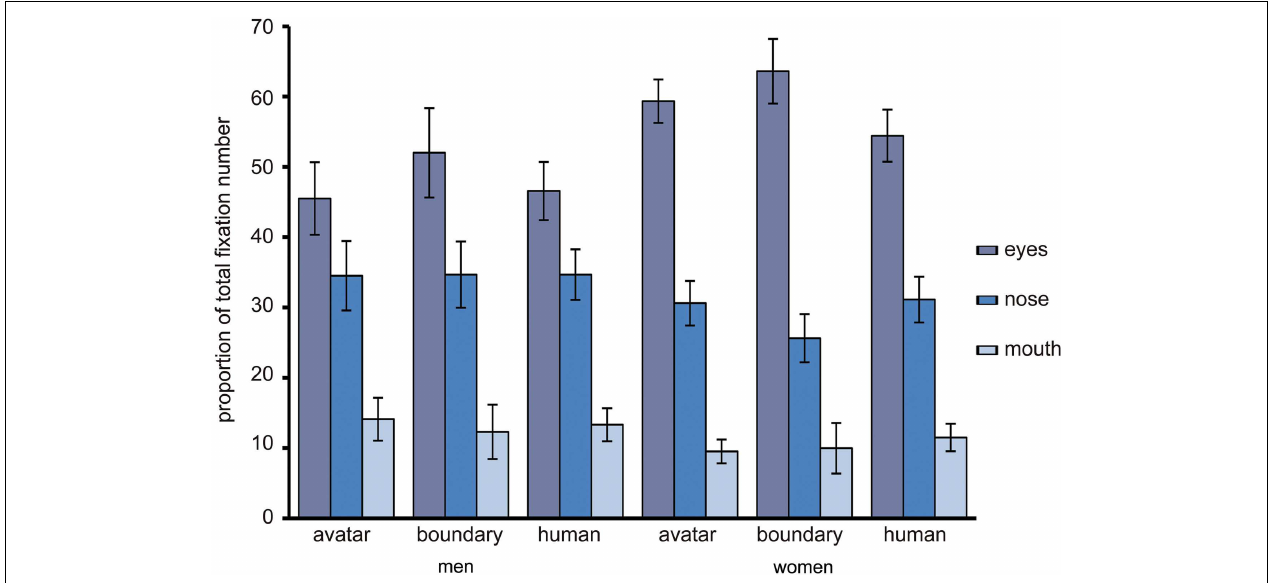
FIGURE 6 |The proportion of total fixation number to the eyes, nose, and mouth. The relative proportion of total fixation number to the eyes, nose, and mouth for the avatar and human categories and for the peak in uncertainty at the category boundary, with error bars as standard errors ( N = 53).